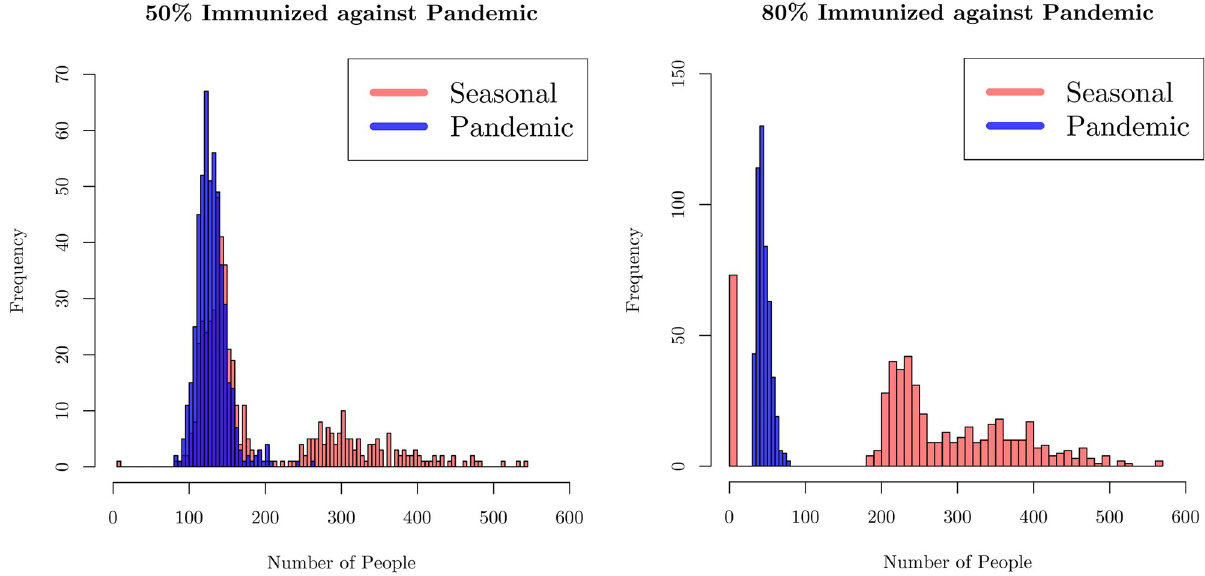
Fig 13. Histograms of the maximum number (defined as the highest number at a given time over the entire season) of infected people with either the seasonal or pandemic strain of influenza in a season. In the left figure, half of the population has been inoculated against the pandemic strain, whereas in the right figure, 80% of the population has been inoculated. We see a natural reduction in the number of pandemic cases, but also a rightward shift in the number of seasonal cases, indicating that a higher level of immunization to the pandemic strain increases the susceptibility of the population at large to the seasonal